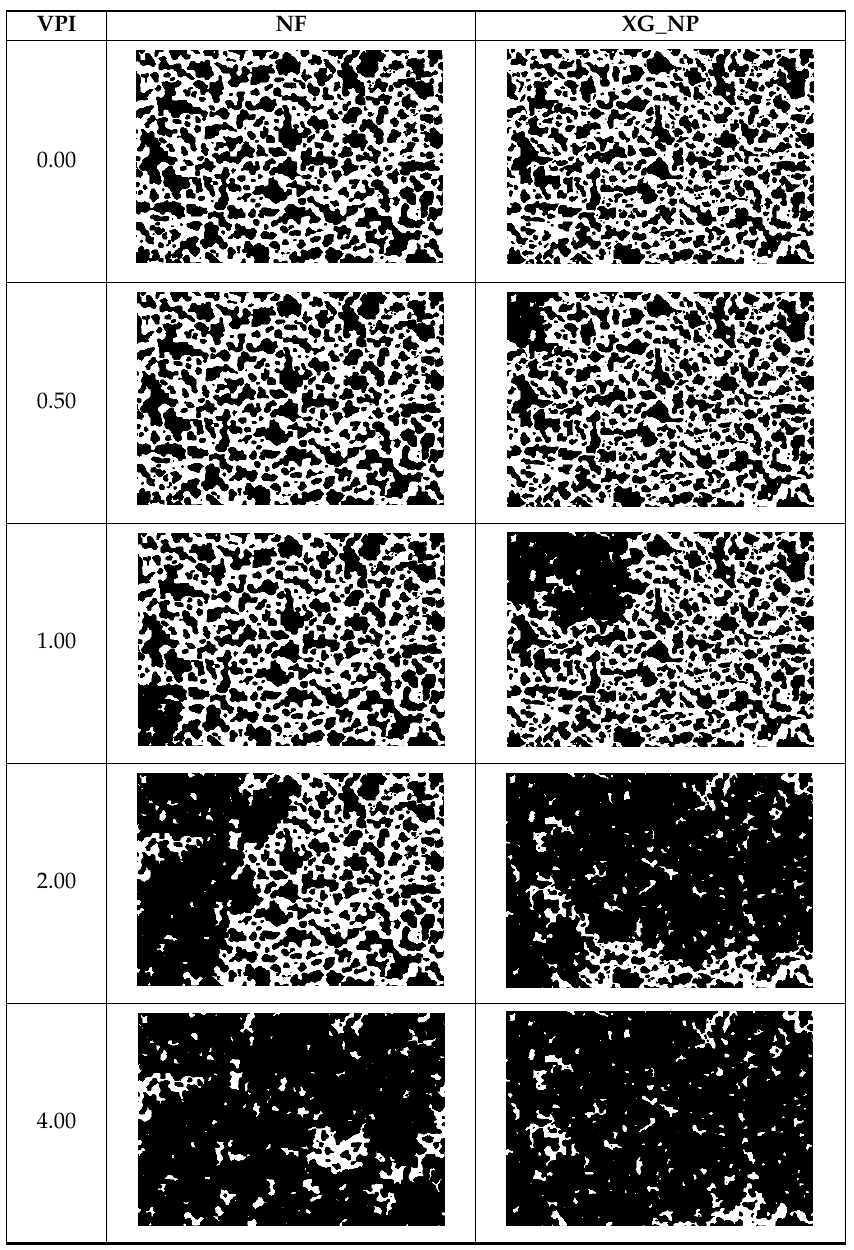
Table A3. Images segmented from the microfluidic tests to evaluate the effect of the flow rate on the recovery performance of the xanthan gum with NPs (XG_NP) in comparison with the reference nanofluid (NF).